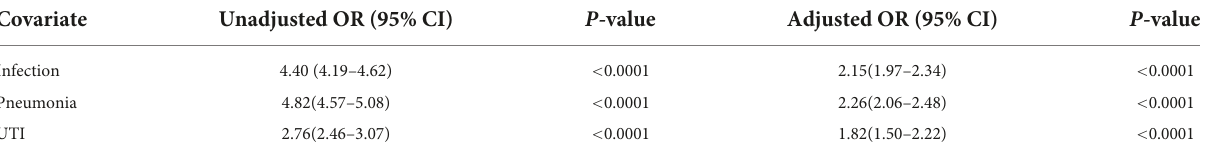
TABLE 2 Association between stroke-associated infection and early poor functional outcome.